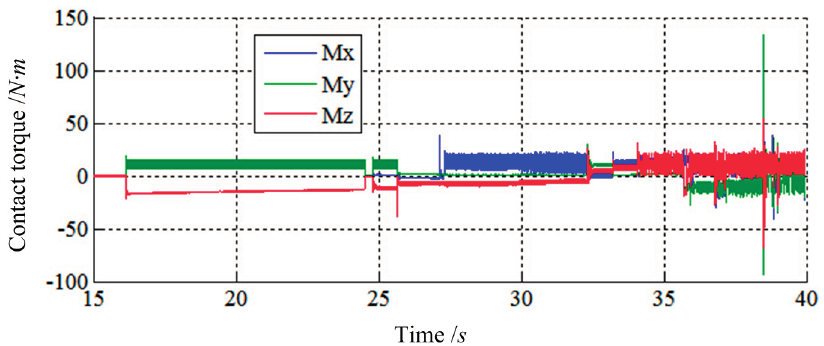
Figure 19. The torque tracking results of Case